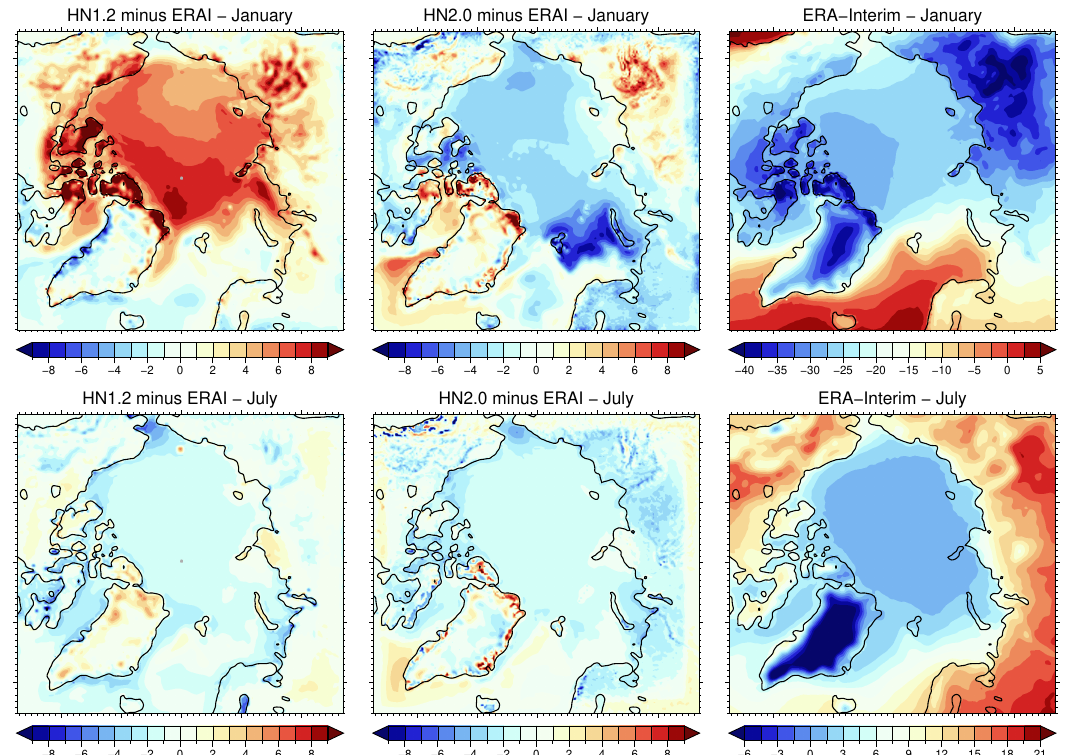
Figure 8. Climatological difference in 2-m air temperature (in degrees Celsius) for January ( top ) and July ( bottom ) from ERAI-driven ensemble simulations with HN1.2 ( left ) and ERAI-driven ensemble simulations with HN2.0 ( middle ). The difference relates to ERAI data ( right ). ERAI data were interpolated to the HIRHAM5-grid. The black lines represent the coastlines of HIRHAM5, defined as 50% land-sea fraction. All data refer to the period